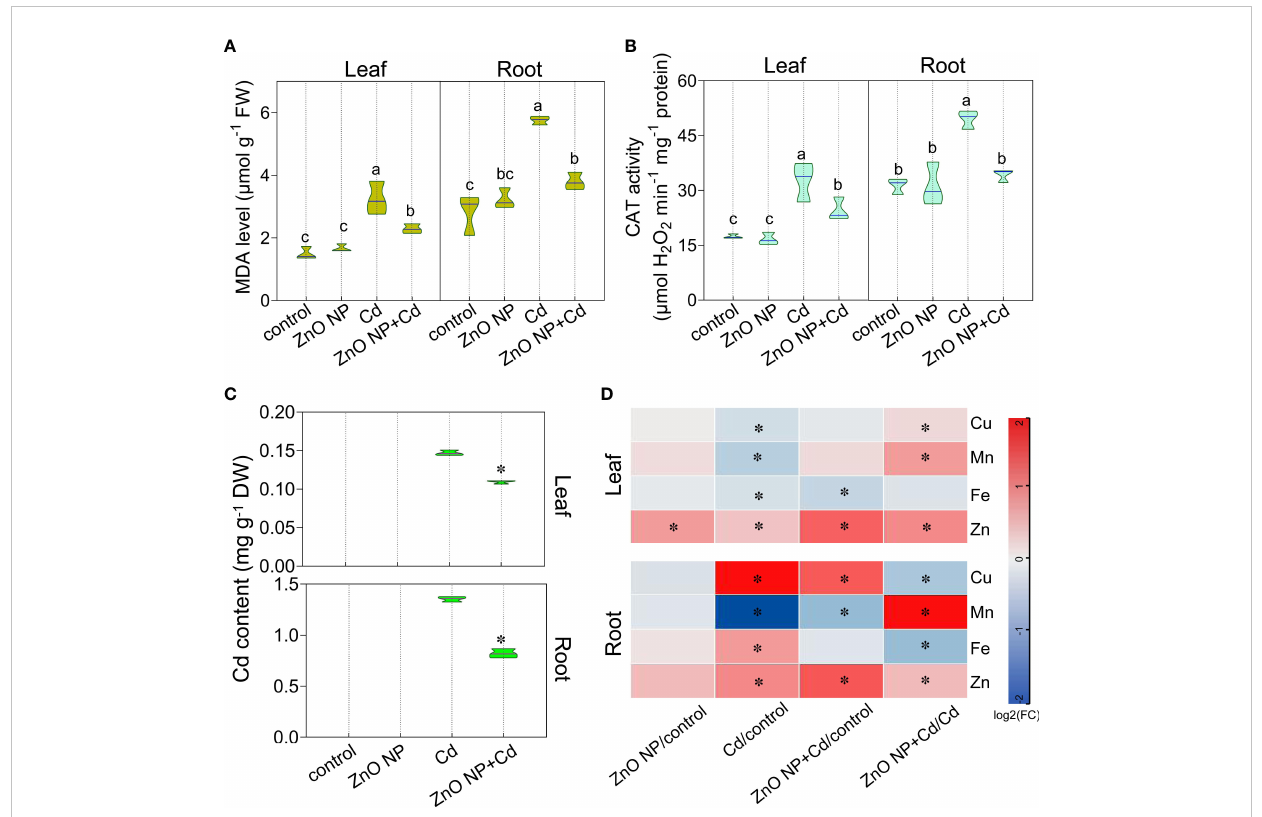
FIGURE 3 ZnO NPs alleviate Cd-induced oxidative damage and reduce Cd accumulation in tomato seedlings. The (A) MDA levels, (B) CAT activity, (C) Cd contents and (D) Cu, Mn, Fe and Zn contents were determined in tomato seedlings. The heatmaps in (D) show the log 2 FC values of the different treatments compared with the control (D) . The results shown are the mean ± SE ( n =3; 15 plants/treatment/repeat). Different letters indicate signi fi cant differences ( P < 0.05 according to Tukey ’ s test). * indicates signi fi cantly different values at P < 0.05 according to Student ’ s t